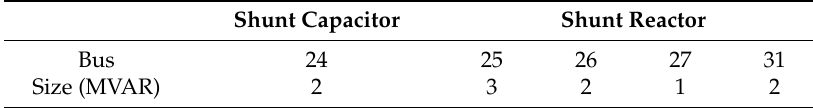
Table A2. Location and size of VAR compensator in Case